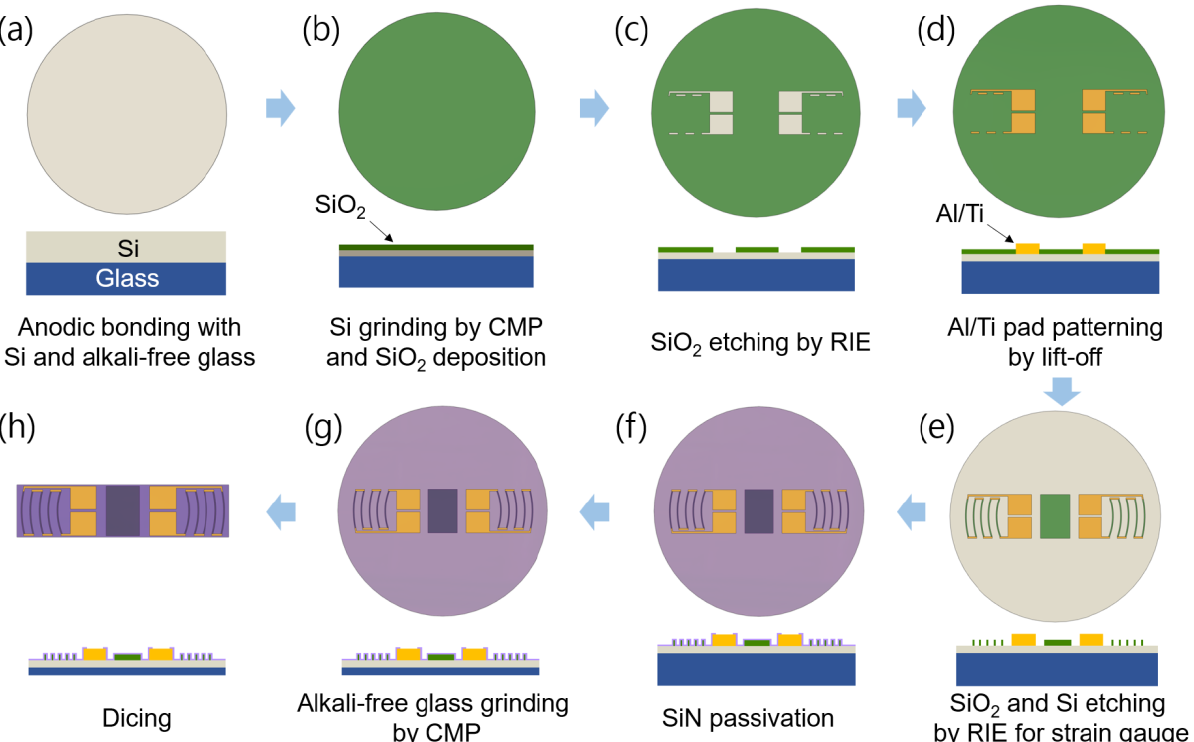
Figure 7. Fabrication process for reciprocating arc-shaped silicon strain gauges.